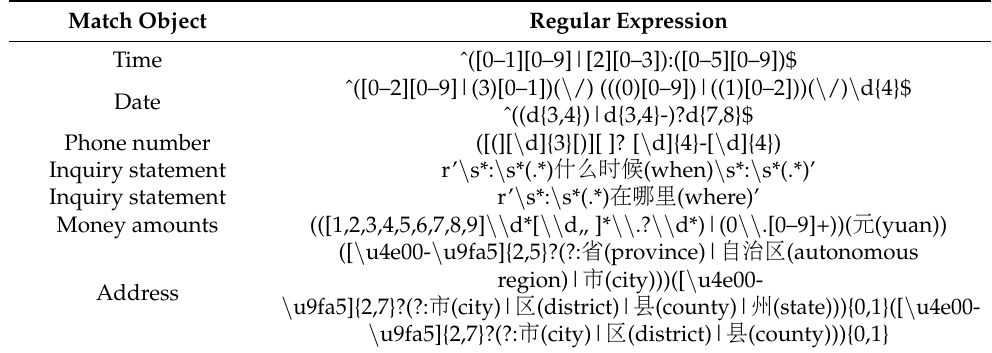
Table A1. Several regular matching examples.